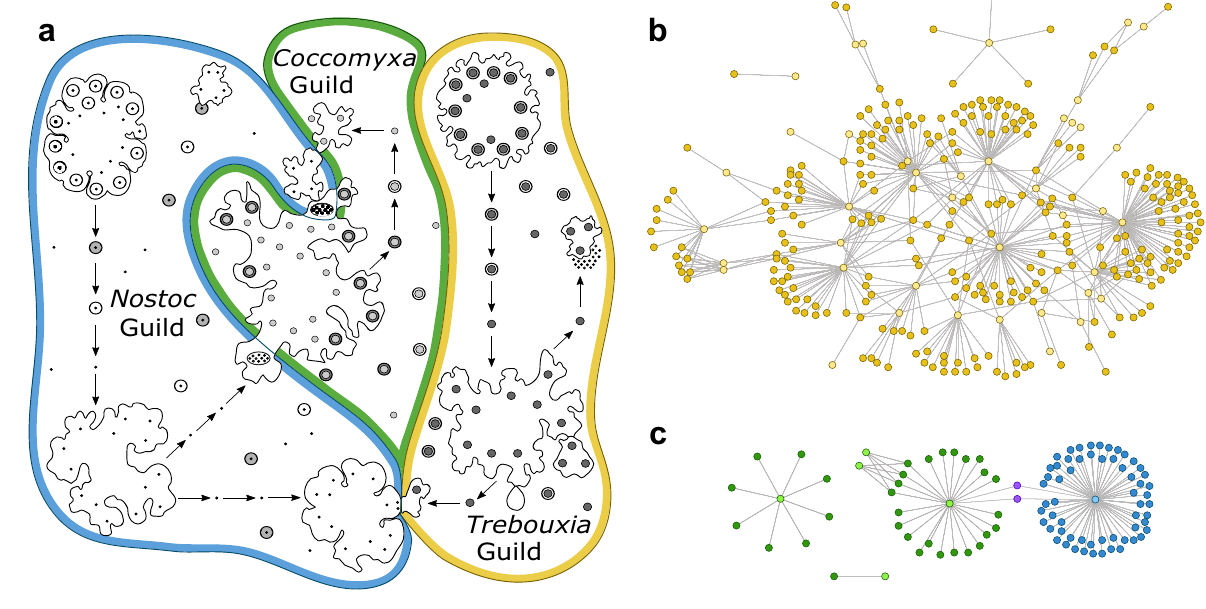
Figure 6. Evolution of photobiont-mediated guild networks. ( a ) Schematic representation of the guild relationships and composition as proposed by Rikkinen (adapted from 29 ). An updated view of the Trebouxia guild ( b ), as well as the Coccomyxa guild ( c ). Network visualizations were generated with OGDF library (see “Materials and methods”).